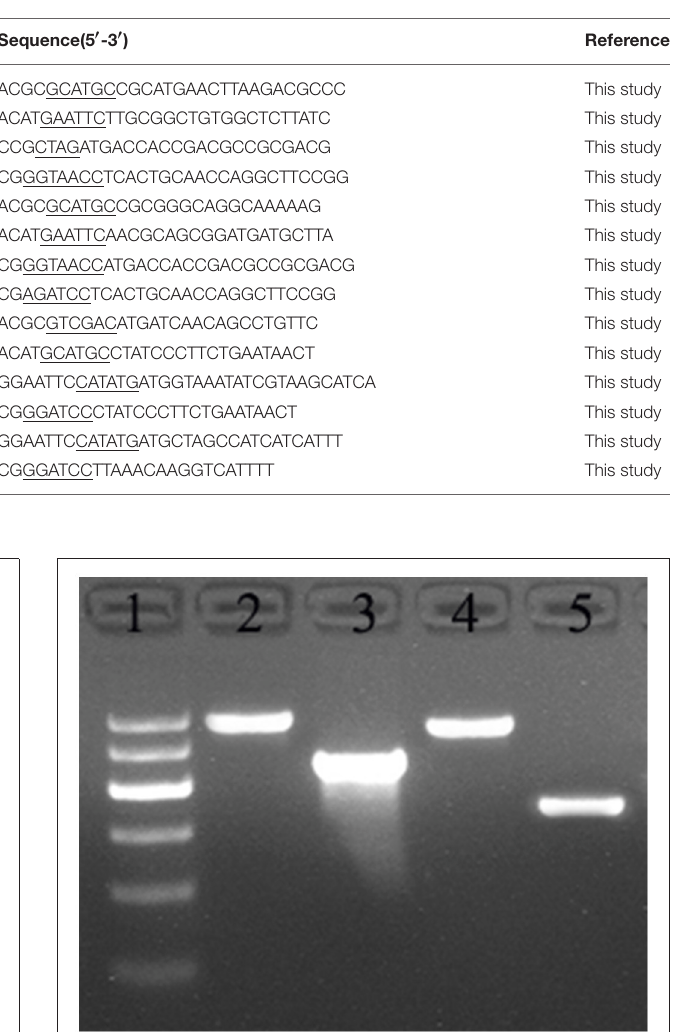
TABLE 3 | Primers used in this study.